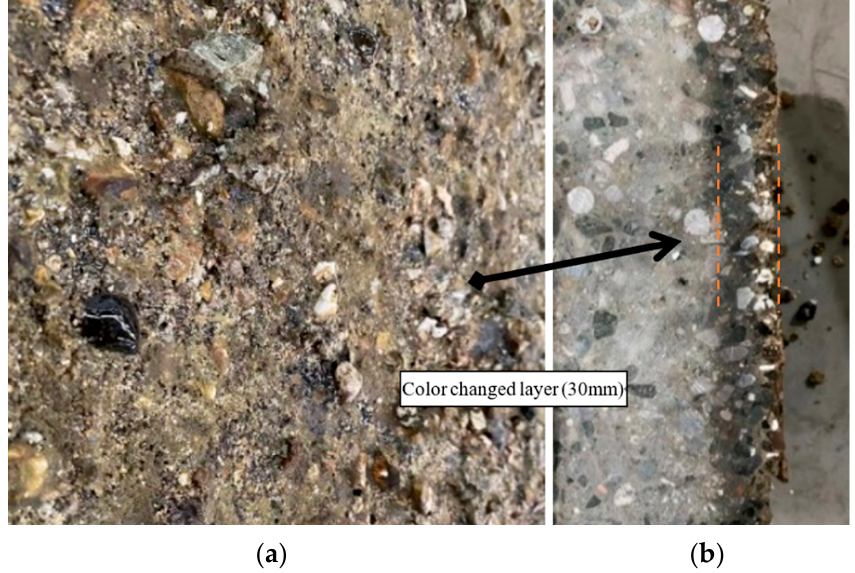
Figure 9. The surface ( a ) and cross section ( b ) of the concrete lining structure (central section).